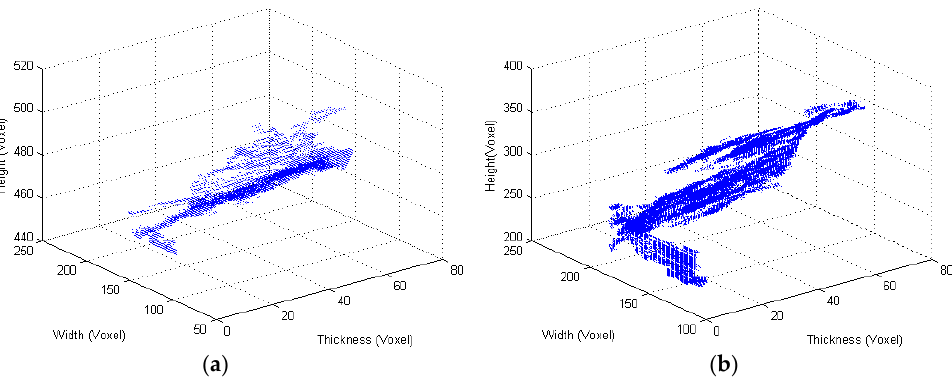
Figure 9. Crack detection results (10 voxels ≈ 7 mm) with restriction on the investigation box (Ψ = 0.5): ( a ) seed voxel #1; ( b ) seed voxel #2.